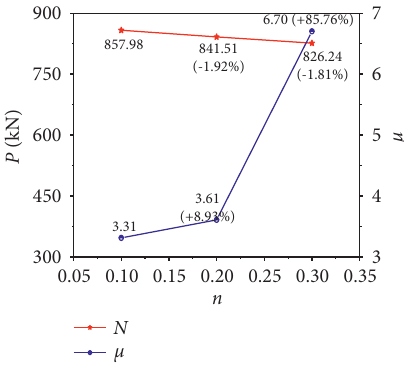
Figure 16: Relationships between P